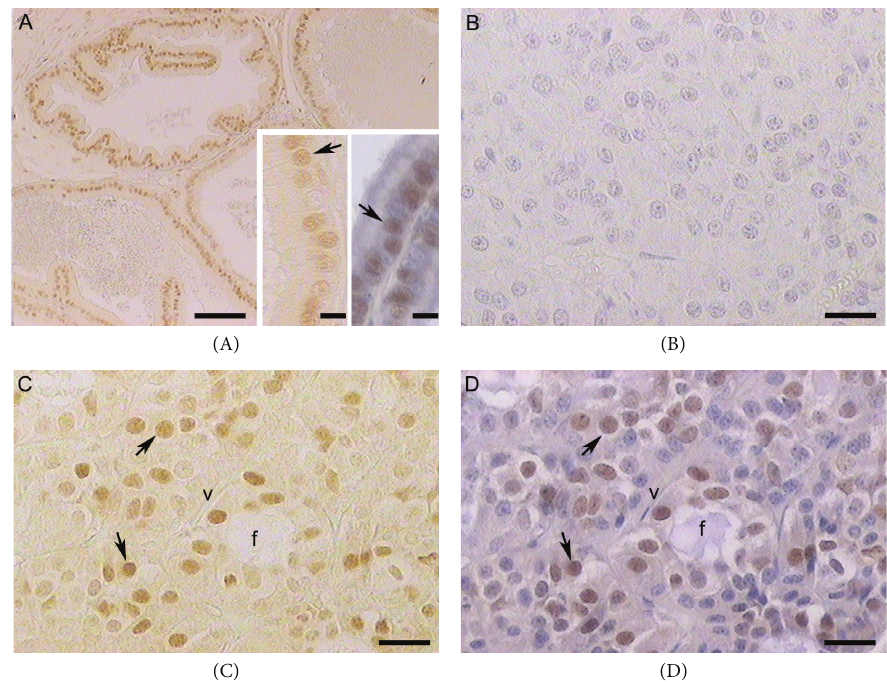
Figure 1: (A) Rat prostate, a positive control of immunoperoxidase staining with anti-AR (N-20) without hematoxylin staining. Insets: immunolabeled nuclei of epithelial cells (arrows) without (left) and with (right) counterstained hematoxylin. (B) Pituitary of viscacha, a negative control of immunohistochemistry counterstaining with hematoxylin. ((C), (D)) Pituitary of viscacha, staining with anti-AR (N-20) without hematoxylin staining (C) and counterstaining with hematoxylin (D). ARn-ir cells (arrows). Blood vessels, v; follicular structures, f. (A) Scale bar: 100 𝜇 m. (B), (C), and (D) and insets scale bar: 25 𝜇